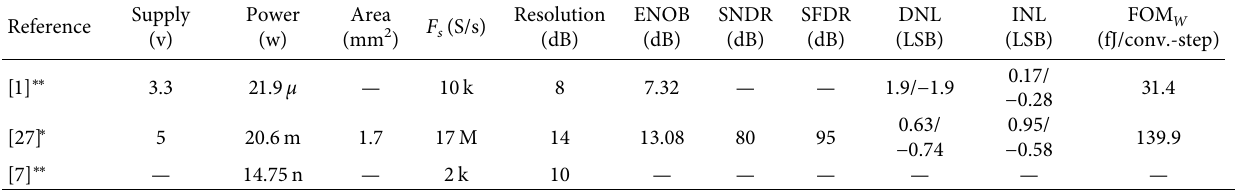
Table 3: Summary of the recently published SAR ADC performance parameters in 500nm process. Reference